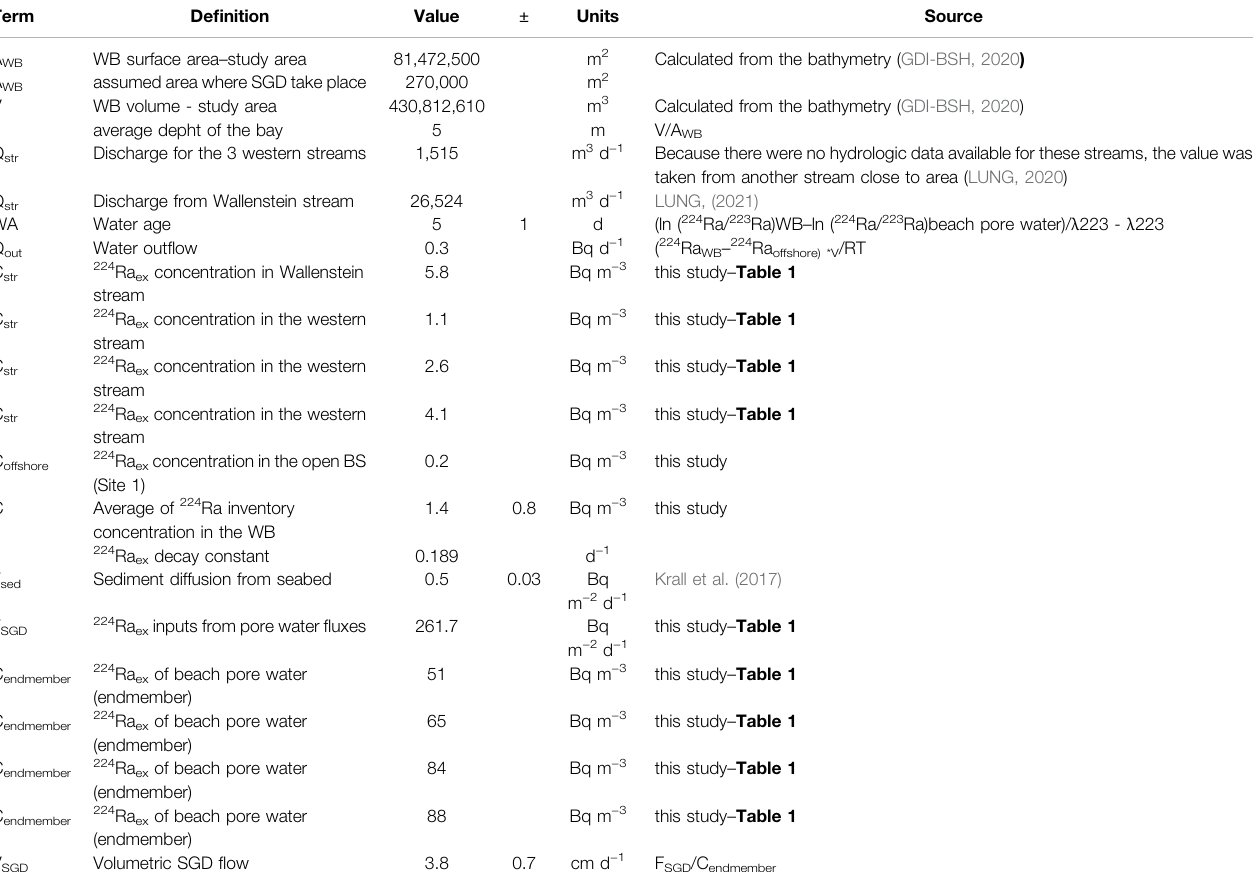
TABLE 3 | Summary of the terms used in the Ra mass